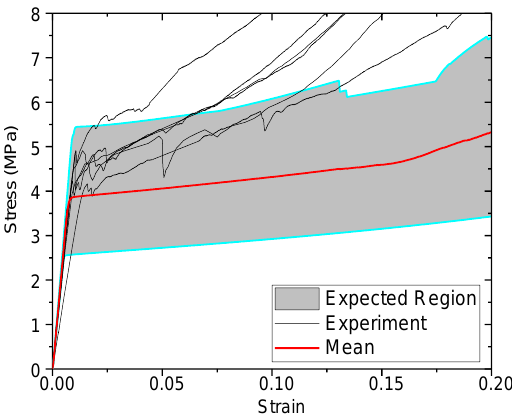
Figure 10. The stress–strain curves extracted from the FE model and tested specimens. Young’s modulus was calculated using the data of the linear part of the stress–strain curve. Figure 11 display the numerically and experimentally derived Young’s moduli and yield stress. Error bars are used to display the bounds of the expected region. Five experimental results are reported. It was found that almost all the tested yield stress was located within the expected region. However, the predicted Young’s modulus was a little bit higher than the experiment results. This might be due to the idealization of wood cells as a rectangular shape which introduced fewer geometry imperfections into the FE model than actual.